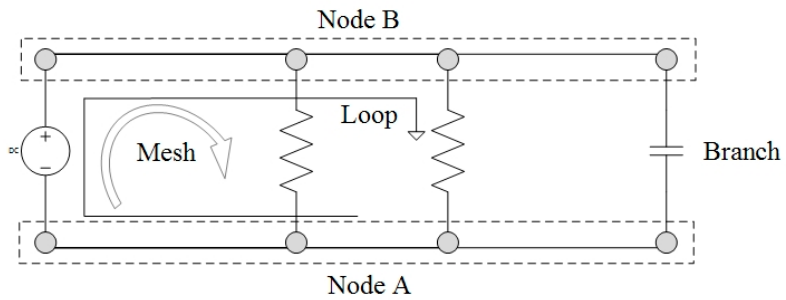
Figure 4. Electric circuit structure and explanation.